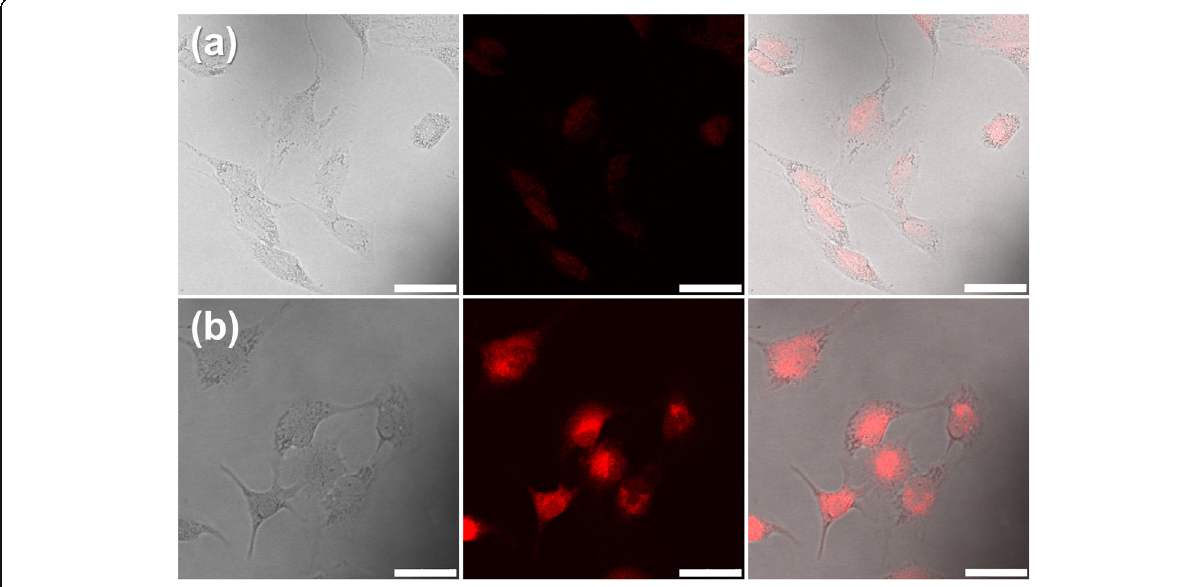
Fig. 7 CLSM images of A549 cells cultivated with DOX-loaded PDA@PMAA nanoparticles for ( a ) 1 h and ( b ) 4 h. In each row, differential interference contrast microscopy images, fluorescence images, and overlay images were shown from left to right, respectively. (scale bar, 50 μ m)